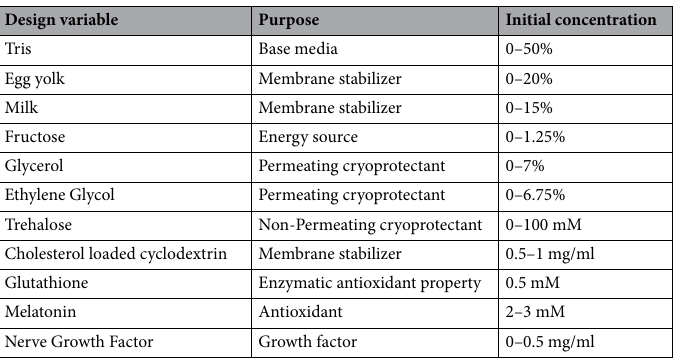
Table 1. Media components used in iterative design and their purpose. Each component concentration is varied during each trial according to predictions from the simulated annealing